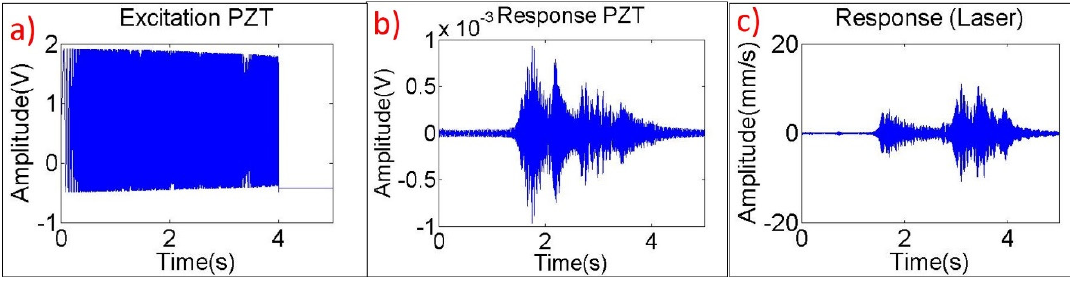
Figure 12. Response of the periphery for the same diametrical mode (326 Hz and second mode). ( a ) Experimental, ( b ) Numerical simulation. Figure 12b shows the mode shape obtained with numerical simulation, which is based on a modal analysis of the bladed-disk using a FEM (Finite Element Method) Model with commercial software ANSYS [37]. A tetrahedral mesh, using SOLID186 [37] elements, was used for the calculation. A mesh sensitivity analysis was conducted, changing the number of elements of the mesh